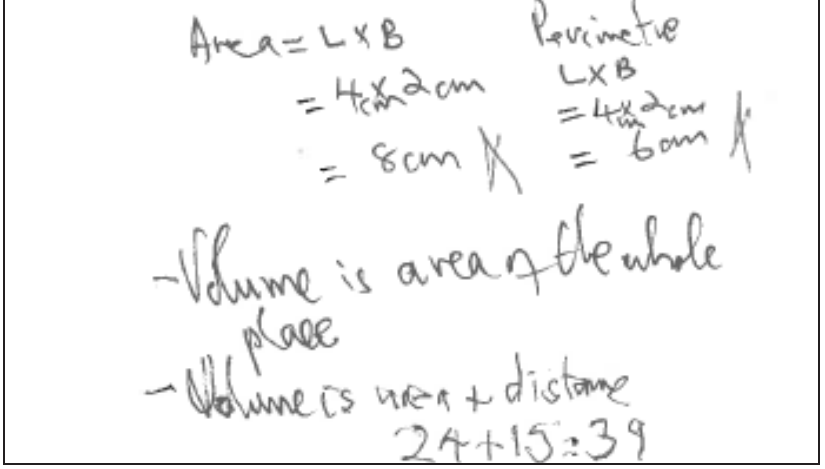
Figure 7: Erroneous definitions and calculations of area, perimeter and volume In South Africa, the NCS (RSA DBE 2010) requires learners to be conversant